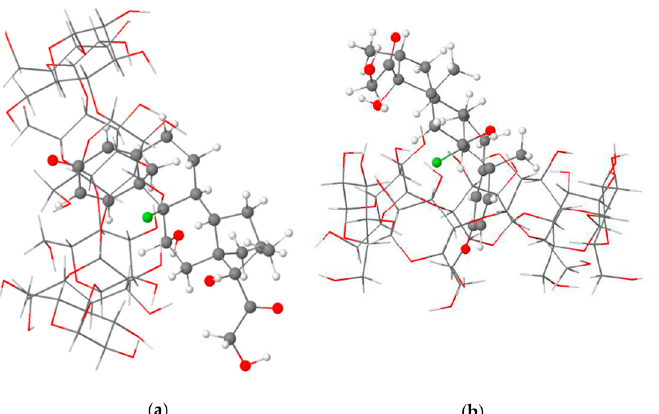
Figure 7. Side ( a ) and top ( b ) views of the partial inclusion of dexamethasone(DEX) in the β -CD cavity as calculated at the BLYP-D4/def2-TZVP level of theory in the gas phase. The structural analysis of the most stable DEX enclosed into the β -CD complex in the gas phase and an aqueous solution indicated the partial inclusion of the dexamethasone in the β -CD cavity from the wider rim (mode A). Adapted from [53], under Creative Common CC BY